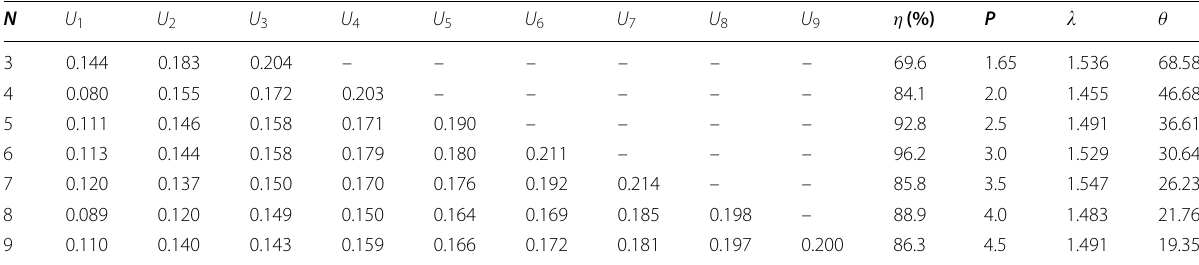
Table 3 Crucial parameters of phase-gradient metasurfaces consisting of different numbers of elements N U 1 U 2 U